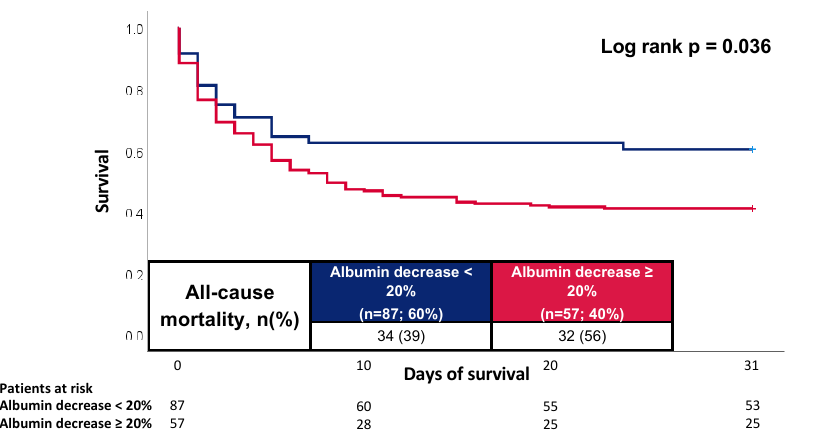
Figure 4. Prognostic impact of albumin decrease from day 1 to day 3 of ICU treatment on the risk of all-cause mortality at 30 days. Table 6. Prognostic impact of albumin decrease within uni- and multivariable Cox regression analyses.